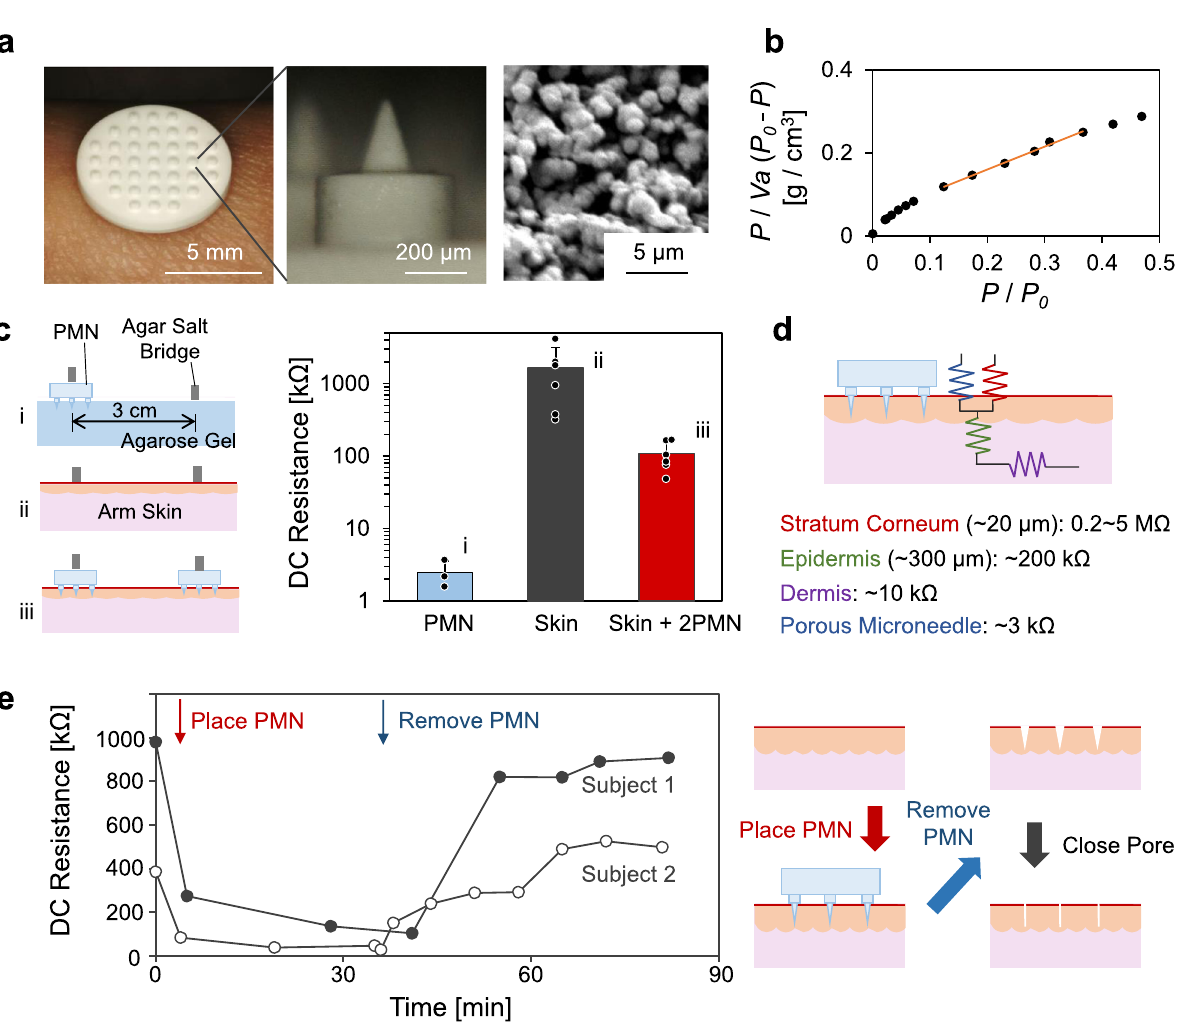
Fig. 2 Structural and electrical characterization of porous microneedles (PMN). a Representative photographs of a chip of PMN arrays and a representative cross-sectional SEM image of PMN ( N = 3 independent samples). b A BET plot for nitrogen adsorption in PMN. V α [cm 3 /g] is the adsorbed gas volume per the weight of PMN at STP. P and P 0 are the monitored and the saturation pressure [Pa], respectively. c The DC resistance of (i) a PMN ( N = 3 independent experiments; mean ± standard deviation (SD)), (ii) human arm skin ( N = 6 independent experiments for 3 human subjects; mean ± SD), and (iii) the skin with PMNs ( N = 6 independent experiments for 3 human subjects; mean ± SD), measured by applying 1 µ A. d Schematic of the equivalent DC circuit of a layered structure of a skin with the experimental resistances of each layer. e The time-course of DC resistance of two human subjects ’ arm skin, in which the red arrow and the blue arrow indicate the timing when the PMN was placed and removed, respectively. During the period of PMN insertion, a tubular salt-bridge was put on the PMN as in ( c -iii). Right illustration draws the pore closure after the removal of